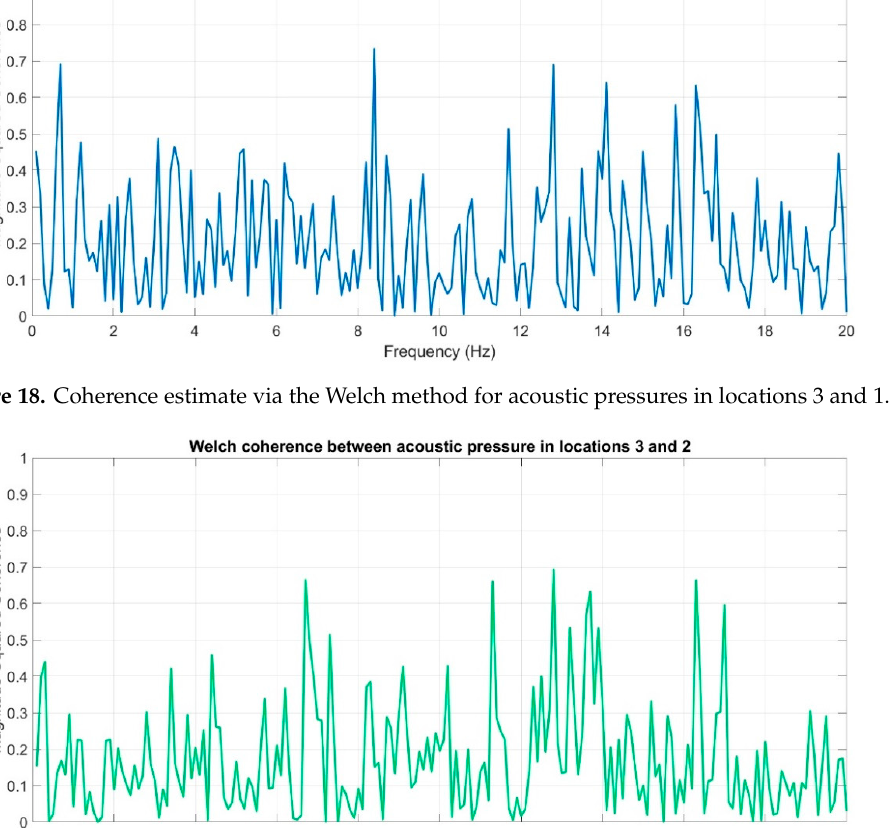
Figure 19. Coherence estimate via the Welch method for acoustic pressures in locations 3 and 2.